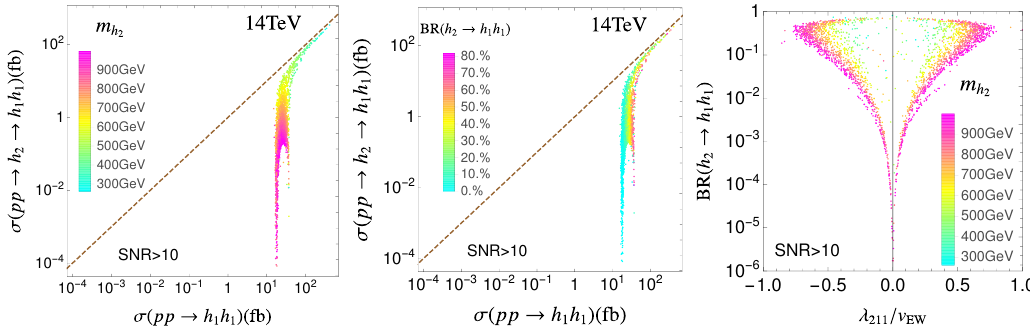
Figure 8 . Resonant contribution to the cross section for di-Higgs production, versus the total cross-section. The left plot shows the correlation of the two cross sections, with the colors denoting values of m h . The middle plot has the colors switched to the branching ratio of h 2 ! h 1 h 1 . The 2 right plot shows this branching ratio versus the trilinear coupling h 2 h 1 h 1 , where the color denotes m h . In the left two plots, the dashed line denotes the place where these two cross sections are 2 the